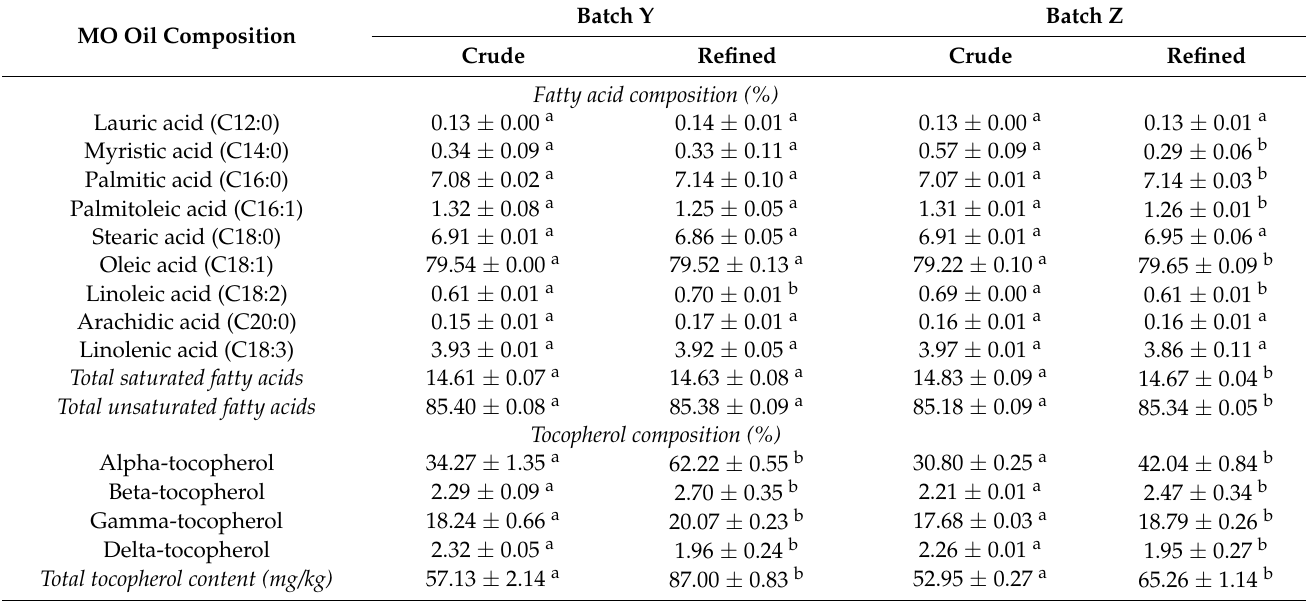
Table 5. Fatty acid and tocopherol compositions of Moringa oleifera (MO) kernel oil (Batches Y and Z). Batch Y Batch MO Oil Composition